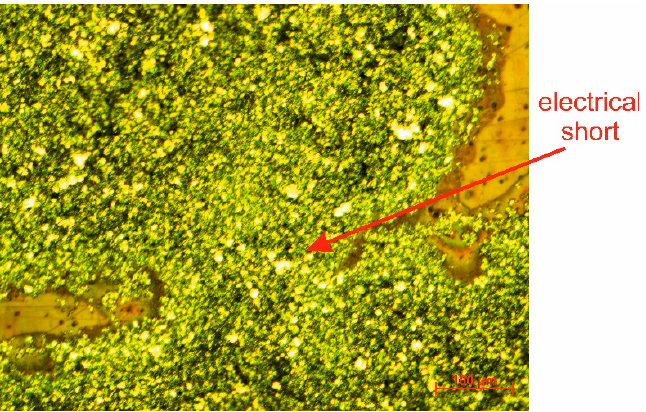
Figure 6. Electrical short caused by the plasma treatment in the case of the paste ED3000 (200 mesh).